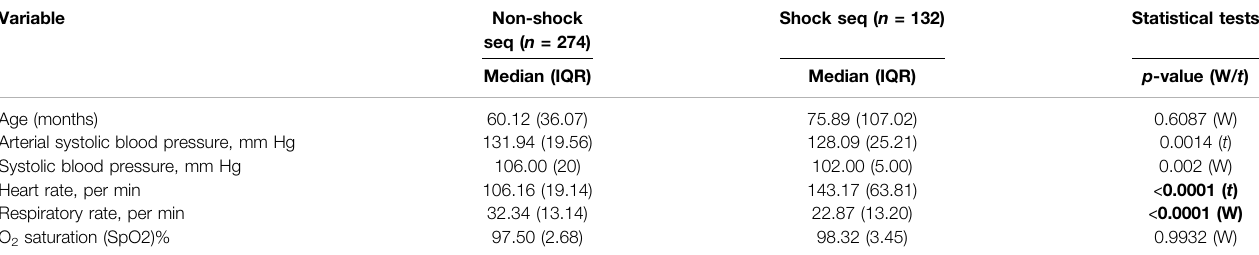
TABLE 1| Cohortcharacteristics andstatisticalsigni fi cance ofcontrol(non-shock)vs.affected(shock) classes. The p -valueswerecalculated usingeither theWilcoxonrank sum test (W) or Student ’ s t-test (t) after testing for normality by the D ’ Agostino-Pearson normality test. ( n , number of sequences; IQR, interquartile range). Variable